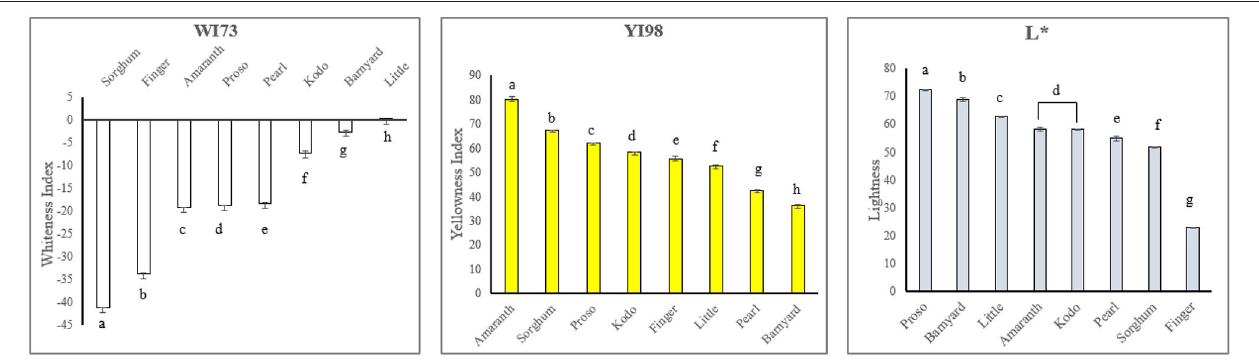
FIGURE 3 | Distribution of Whiteness Index(E313) (73), Yellowness Index(E313) (98), and Lightness (L*) values of Ancient seed grains. For each chart, mean values not connected by the same letter are significantly different (Tukey’s HSD, P < 0.05).